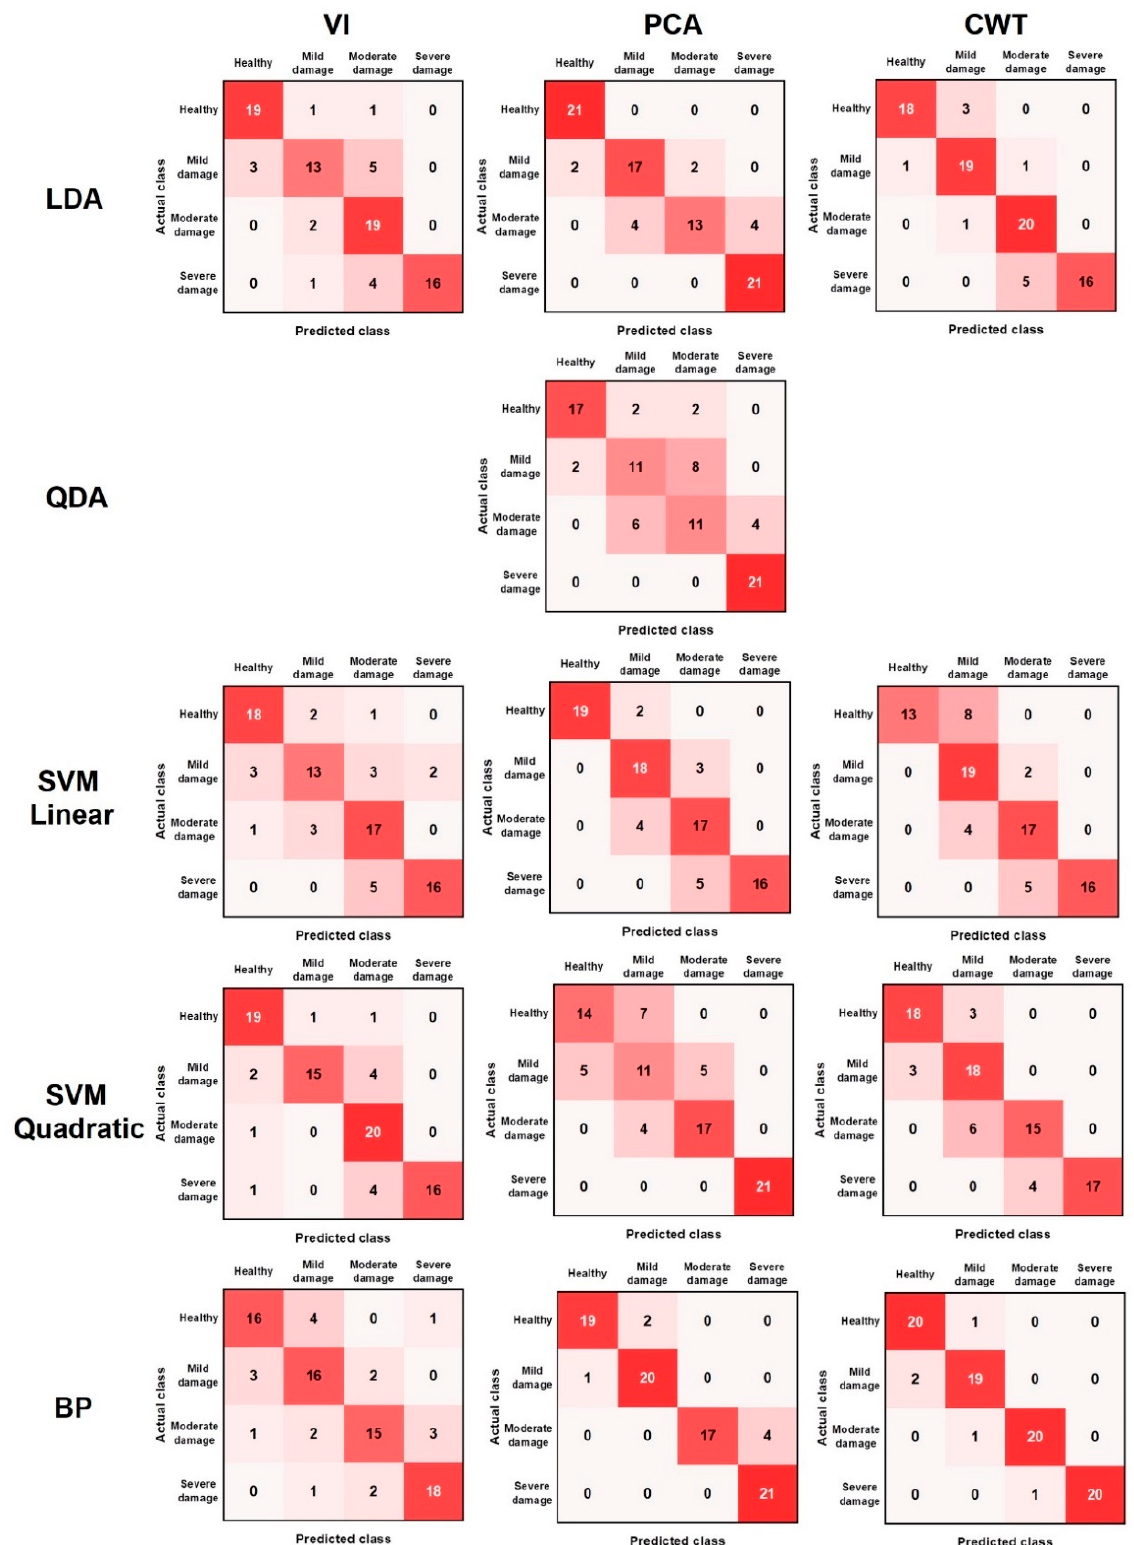
Figure 8. Training accuracy of different classification algorithms ( n = 84). For the validation samples, the PA was 100% (CWT-DA), 100% (CWT-SVM-Linear), 70% (CWT-SVM-Quadratic) and 81.82% (BP) for the healthy category, respectively. The commission error was observed between CWT-DA (21.22%), CWT-SVM-Linear (33.3%), and CWT-SVM-Quadratic (21.22%), respectively. The mild damage produced a lower ac- curacy of 75% (CWT-DA), 63.64% (CWT-SVM-Linear), 70% (CWT-SVM-Quadratic), and a maximum value of 100% in CWT-BP. UA was 100%, 77.78%, 77.78% and 77.78% for